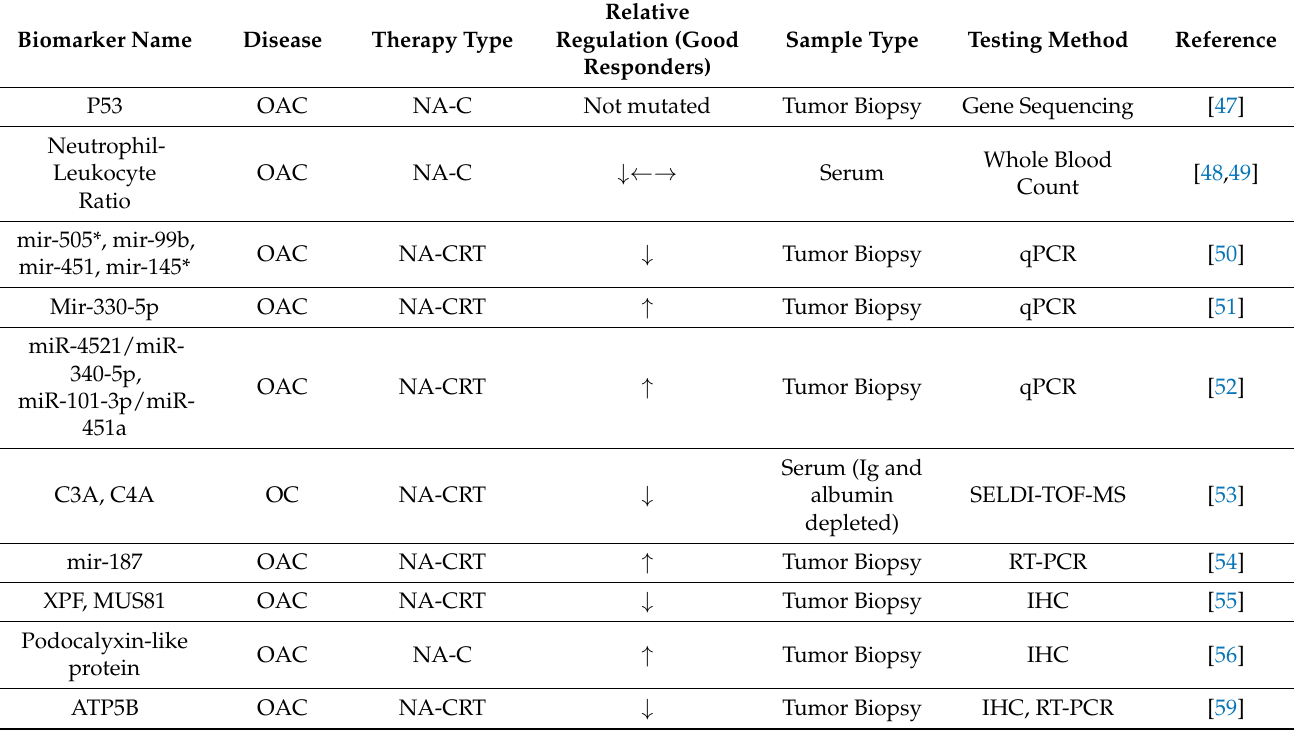
Table 3. Summary table of predictive biomarkers of response to neoadjuvant treatment in